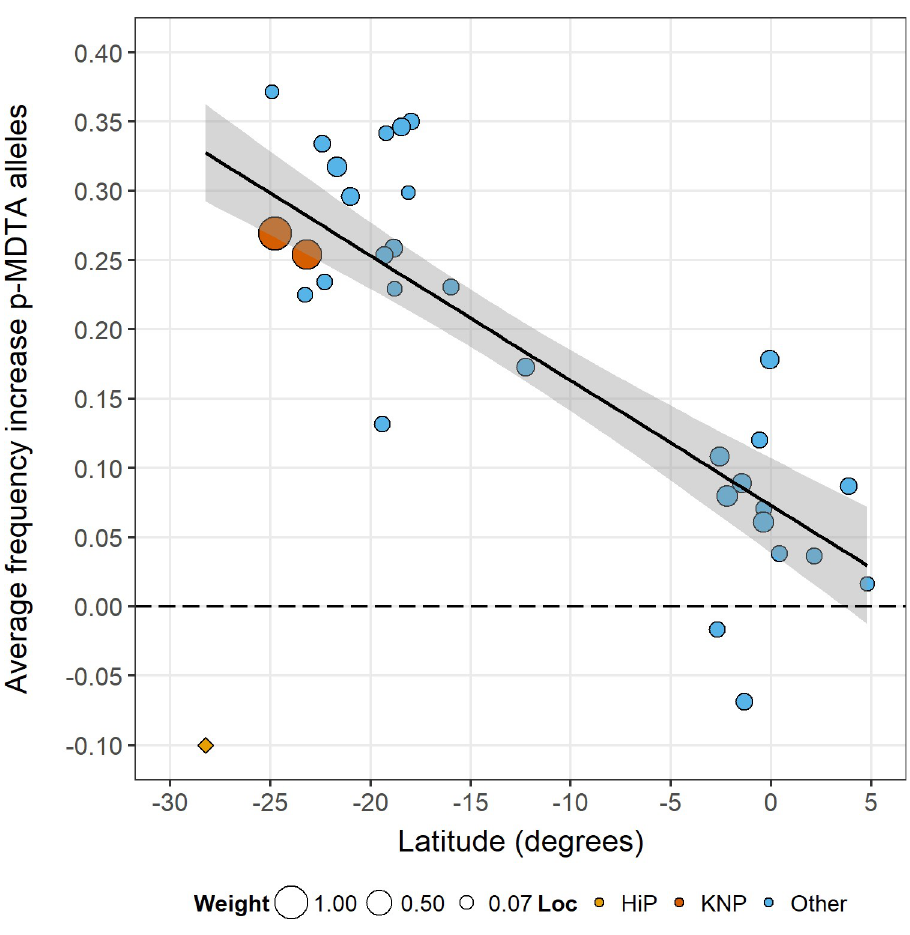
Fig 2. Multilocus-allele-frequency